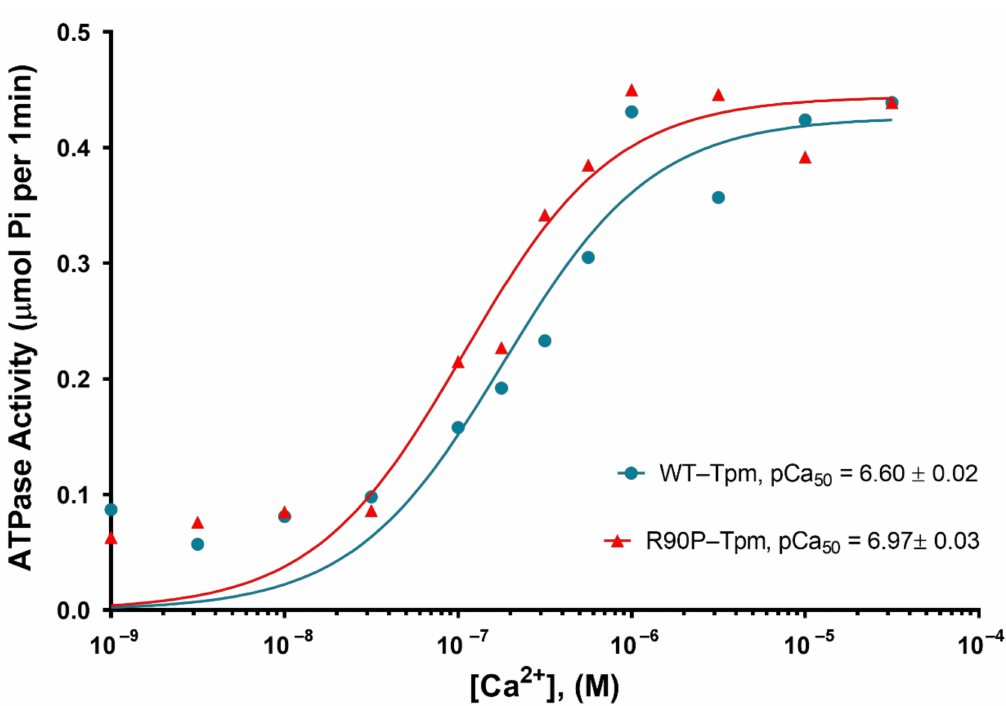
Figure 2. The effects of the increasing Ca 2+ concentration on the actin-activated ATPase activity of S1. Ca 2+ dependence was determined for fully regulated reconstituted thin filaments in the presence of WT-Tpm (blue circles) or R90P-Tpm (red triangles). The figure shows one of the typical graphs. The average values for pCa 50 from 3–4 independent experiments are presented. Errors indicate ± SEM. Other conditions are as described in Materials and Methods.